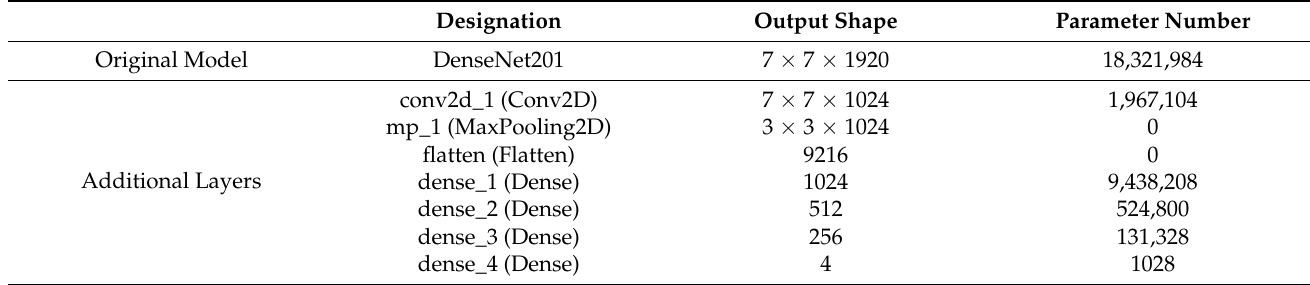
Table 9. The proposed modified-based DenseNet201 model architecture.